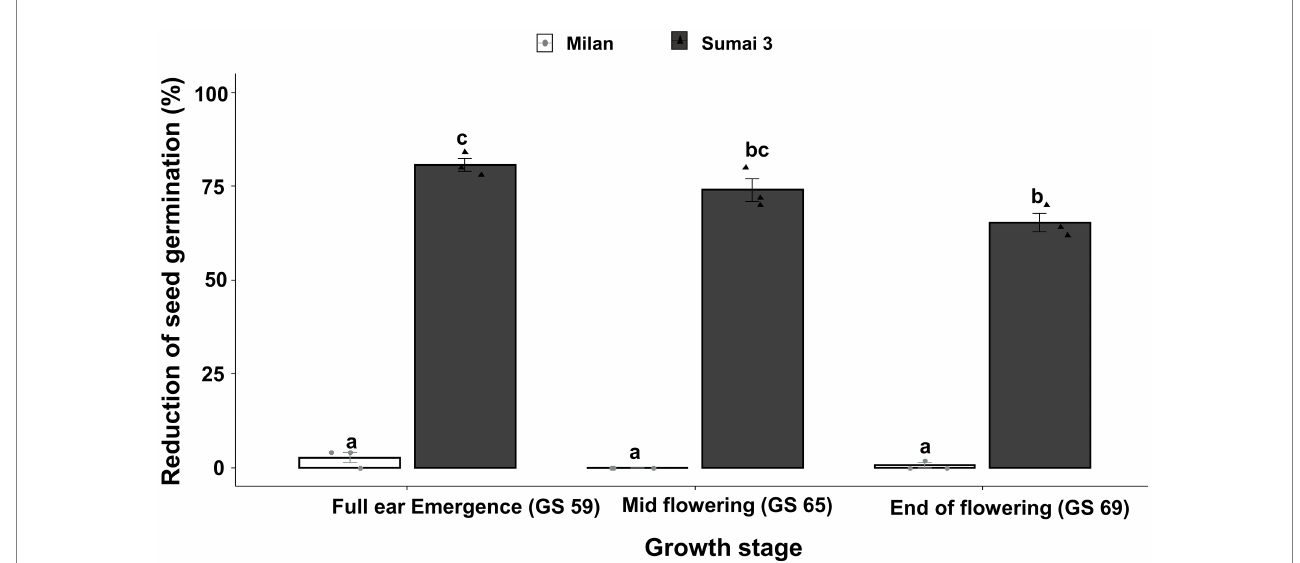
FIGURE 2 Effect of different MoT inoculation time points on the reduction of (%) seed germination of Sumai 3 and Milan in greenhouse conditions. The wheat ears were inoculated with a conidial suspension of 1 × 10 5 conidia/ml at GS 59, full ear emergence; GS 65, mid flowering; and GS 69, end of flowering stages. For each cultivar, the mean (± standard error) of reduction of seed germination (%) of each ear inoculation time point is represented by a bar. ANOVA with Tukey test was performed, and treatments with the same letters at the cultivar level were not significantly different ( n = 3; one replication contained 25 seeds of each cultivar at each inoculation time point; p = 0.05). Each data point represents one replicate consisting of 25 randomly selected